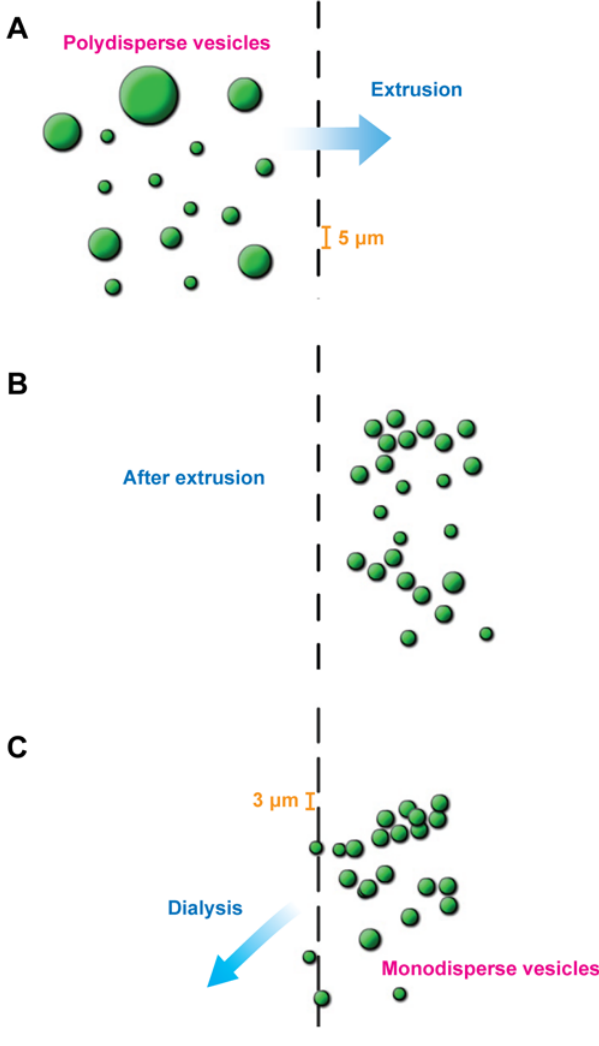
Figure 1. Schematic diagram of vesicle extrusion-dialysis. (A, B) Extrusion of polydisperse vesicles through 5- m m-diameter pores eliminates vesicles larger than 5 m m in diameter. (C) Dialysis of extruded vesicles against 3- m m-pore-size polycarbonate membranes eliminates vesicles smaller than 3 m m in diameter, leaving behind a population of monodisperse vesicles (see also Movie